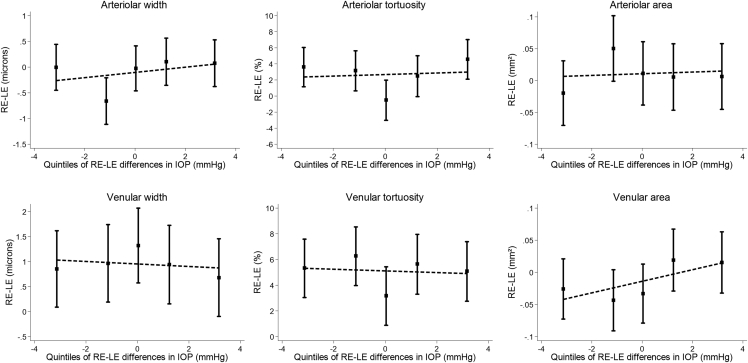
Average between-eye differences in retinal vessel measures by quintiles of between-eye differences in Goldmann-correlated intraocular pressure (IOP) among individuals who do not have a glaucoma diagnosis in either eye. R2 values from linear regression using IOP as a continuous variable are less than 0.001 in all instances.